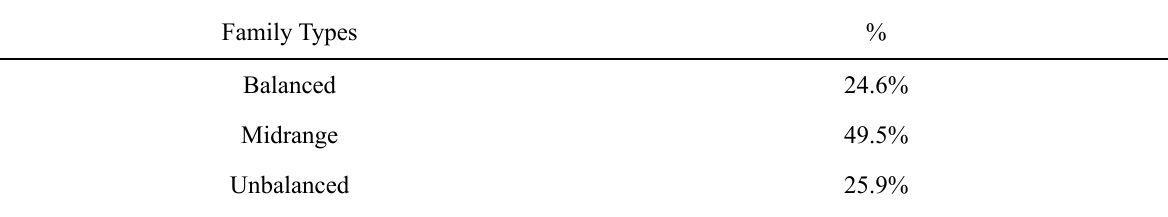
Percentages of Adolescents Belonging to the Different Family Types